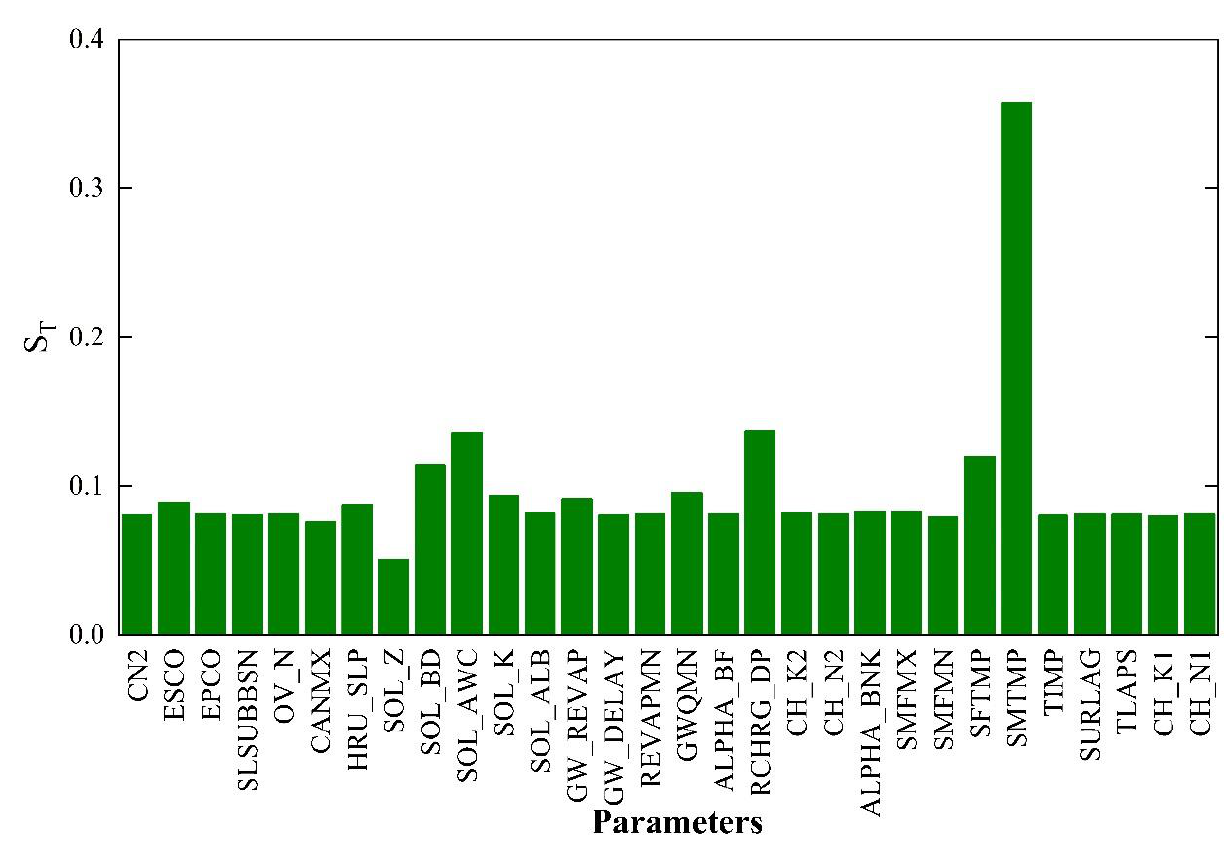
Figure 12 Total sensitivity ( 𝑆 𝑇 ) of each parameter of EFAST.